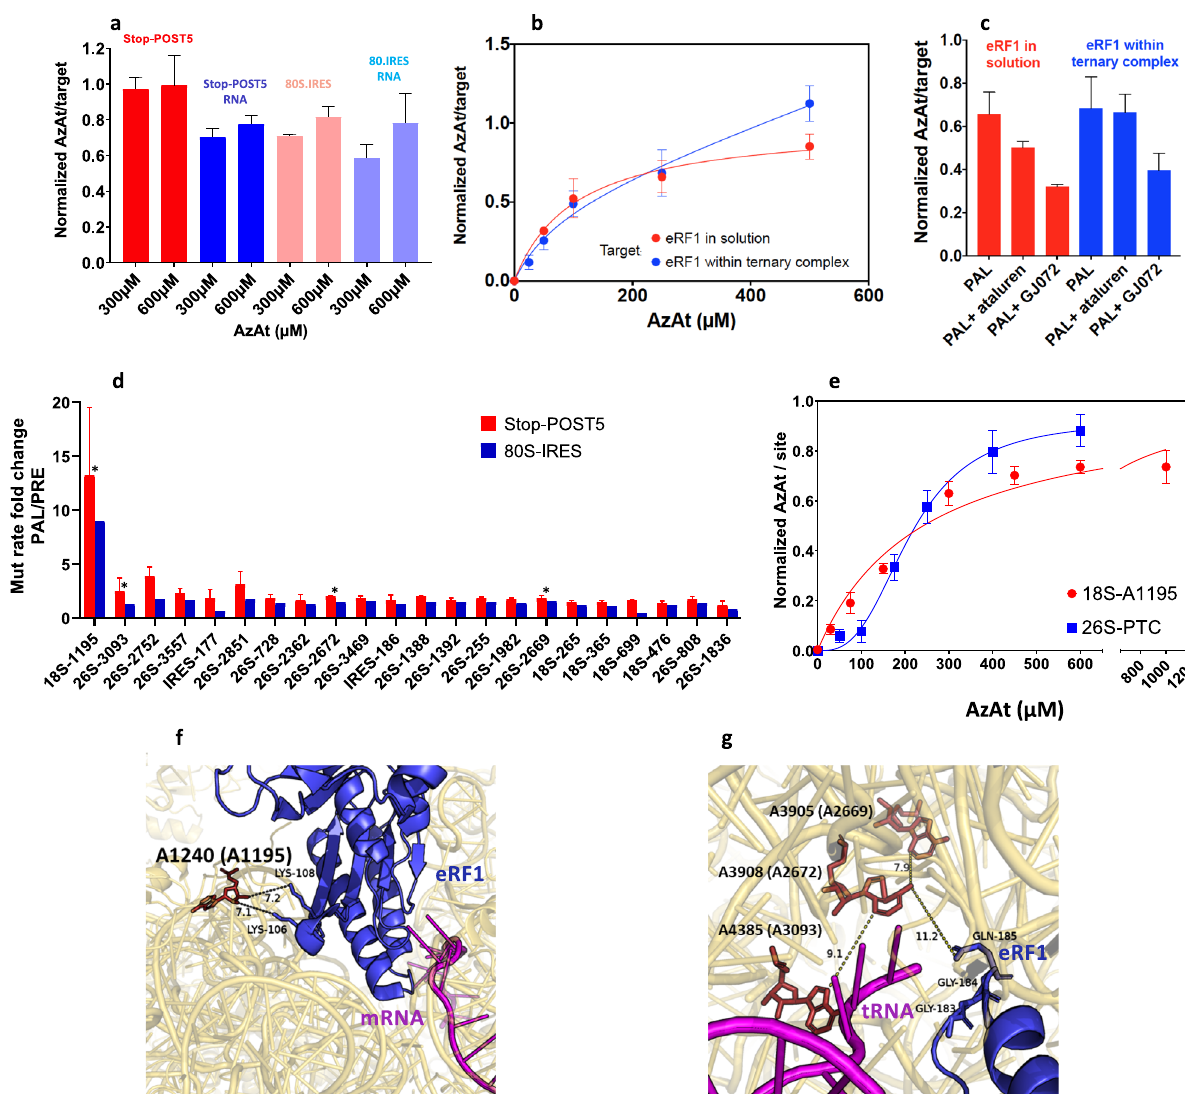
Fig. 2 AzAt Photoaf fi nity Labeling. a AzAt photoincorporation into Stop-POST5, the RNA fraction of Stop-POST5, 80S.IRES, and the RNA fraction of 80S.IRES. All of the labeling stoichiometries are normalized to that of Stop-POST5 at 600 µ M AzAt, which was equal to 1.2/Stop-POST5. b AzAt photoincorporation into eRF1 both alone and complexed with eRF3.GDPNP. The values are normalized to the saturation labeling of isolated eRF1. c Inhibition of AzAt (250 µ M) photoincorporation by the addition of either ataluren (1000 µ M) or GJ072 (150 µ M). d The mutation rate fold change for PAL vs. PRE samples for Stop-POST5 (red) and 80S.IRES complexes (blue) for the 22 sites most pertinent for ataluren function, and the asterisks indicates sites of particular interest (see text). e Saturation curves for photoincorporation into 18S-A1195, as measured by photoincorporation into Fragment I, vs. the sum of the photoincorporations into 26S A3093, A2669, and A2672, as measured by photoincorporation into Fragments II and III. f Location of A1195 within the 40S subunit containing bound eRF1. g Locations of A2669, A2672, and A3093 within the 60S subunit containing bound eRF1. All of the error bars in this Figure represent average deviations for n = 2 independent determinations, with the exception of the eRF1 labeling within the ternary complex in b, for which n = 3. Source data for ( a – e ) are provided as a Source Data fi